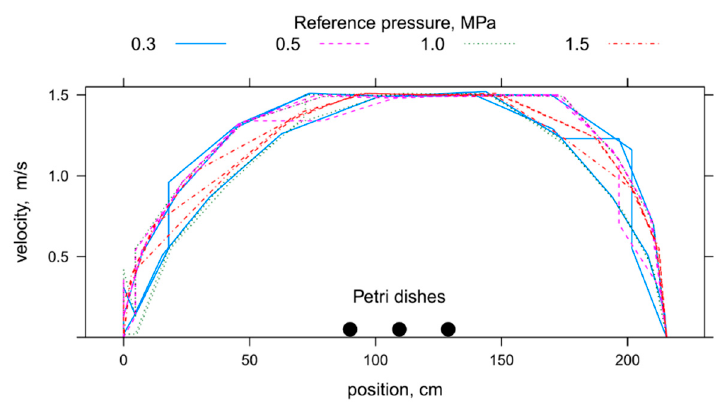
Figure 9. Speed profiles of the mobile platform during the tests.